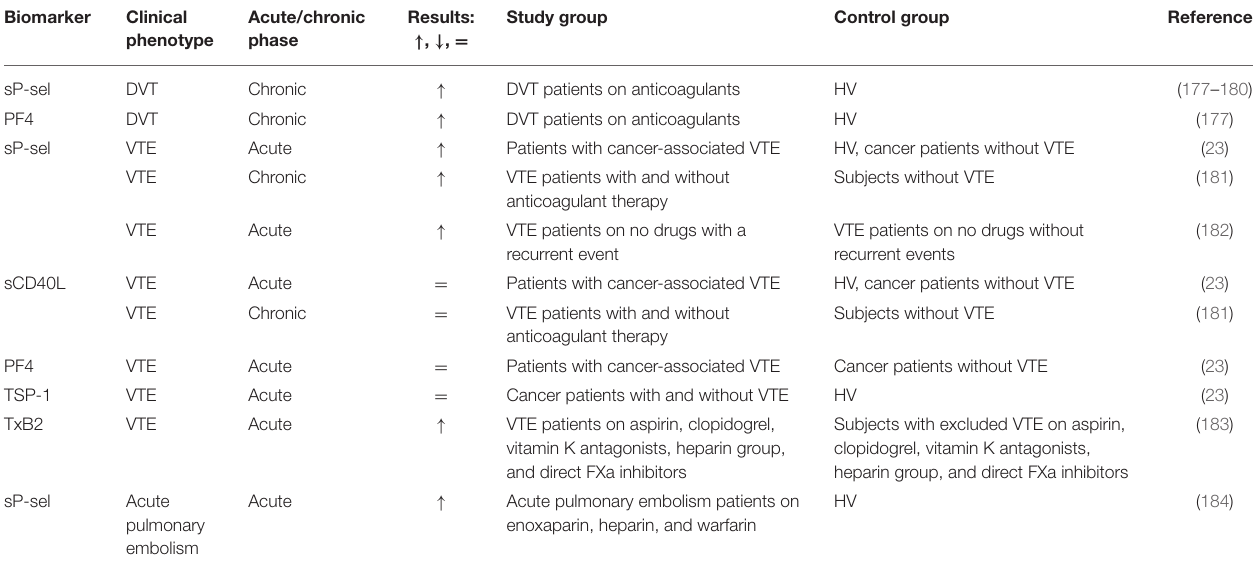
TABLE 6 | Soluble biomarkers of platelet activation in patients with venous thromboembolism